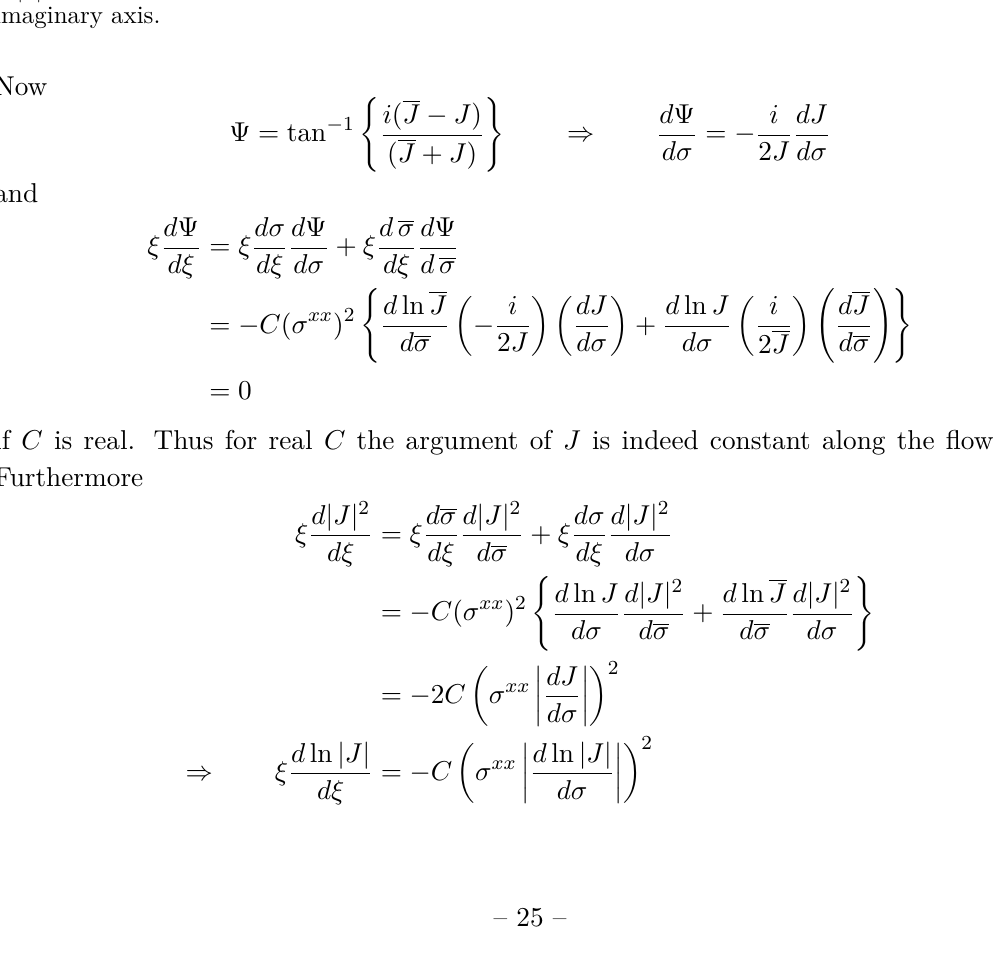
Figure 2 . Temperature as a function of | J | for | J | ≥ 1 along the imaginary axis, with Γ(1) flow. Θ drops monotonically from unity at | J | = 1 to zero as | J | → ∞ . Asymptotically Θ 4 /z ≈ . This assumes that the classical solution gives the correct temperature dependence along the 2 π ln | J | imaginary